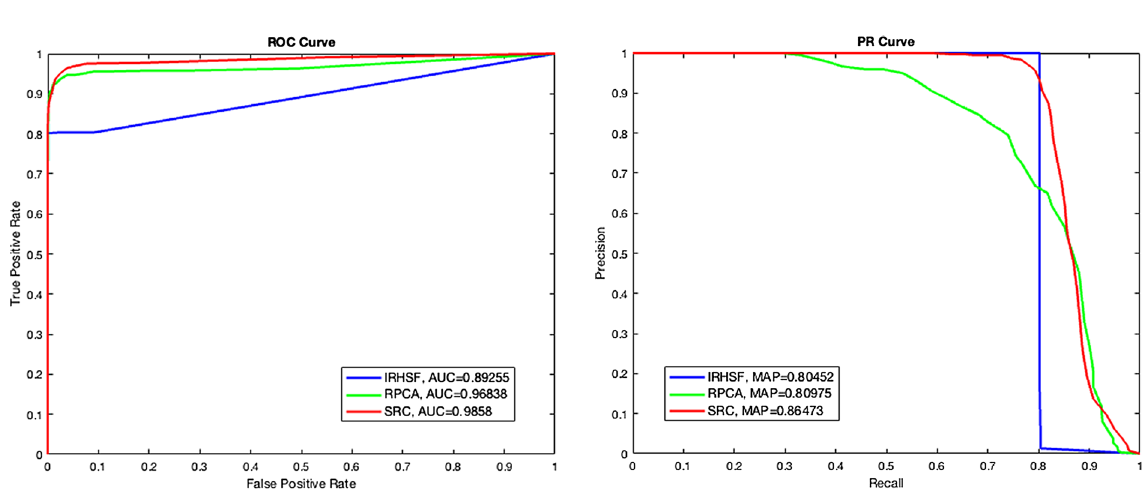
Figure 11. ROC and PR curves of three discussed methods based on the image pair with small